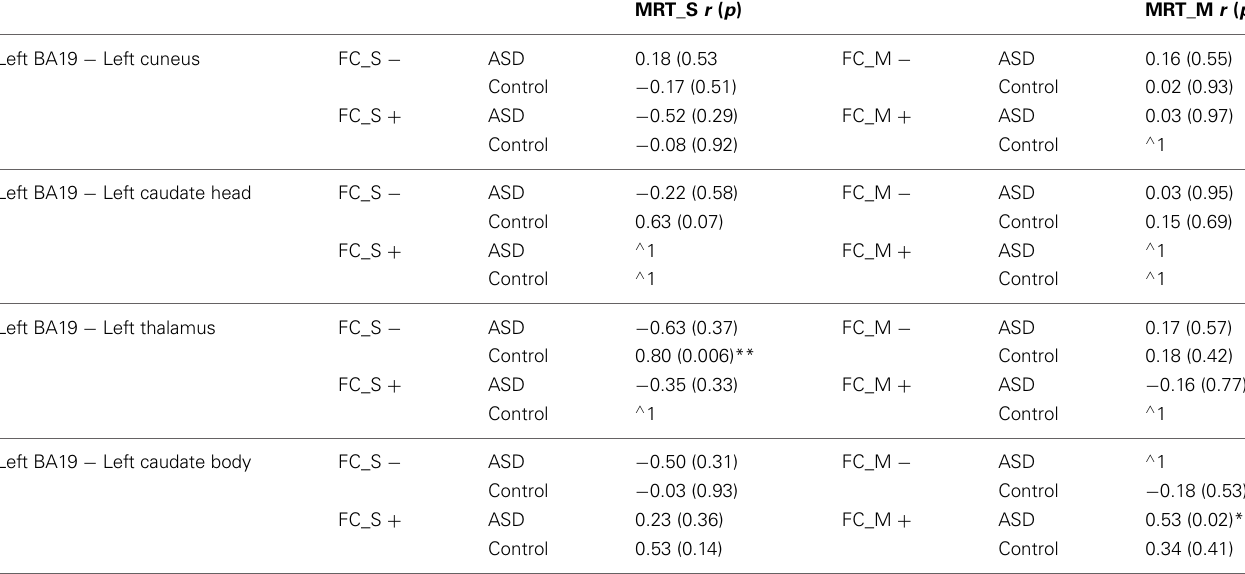
Table 5 | Results of correlation analysis between functional connectivity and mean response times during Same and Mirror trials of a mental rotation task ( p : p -value, r: Pearson correlation co-efficient, FC_S − Negative functional connectivity on Same trials, FC_S + Positive functional connectivity on Same trials, FC_M − Negative functional connectivity on Mirror trials, FC_M + Positive functional connectivity on Mirror trials, MRT: mean response time, ∧ 1 Insufficient data for correlation as all functional connectivity values were negative between seed regions in left BA19 and left caudate